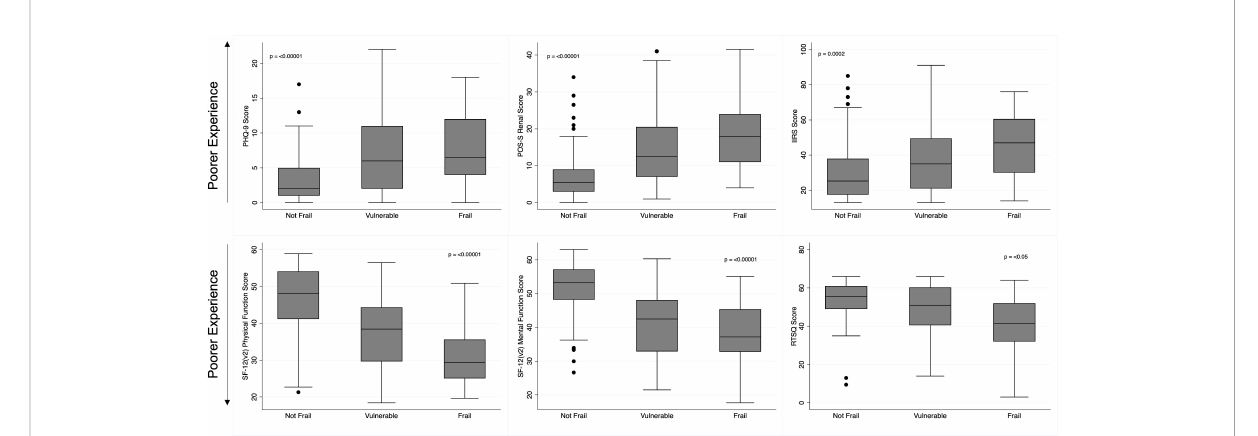
FIGURE 1 Patient Reported Experience Scores by Frailty Status. Box and whisker plot illustrating the distribution of patient experience questionnaire scores by identi fi ed frailty status. PHQ-9, Depression Patient Health Questionnaire, 9; POS-S Renal, Palliative Care Outcome Scale - Symptoms Renal;